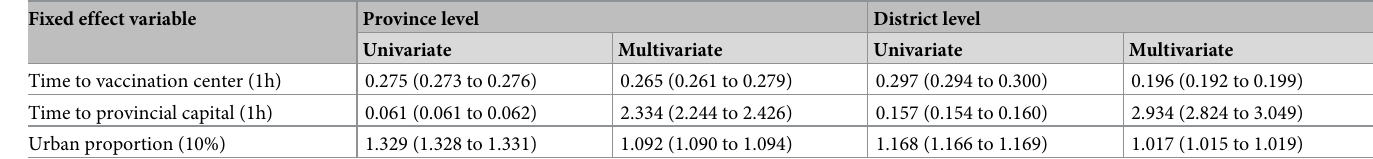
Table 2. Rate ratios for fixed effects (with 95% credibility intervals) in univariate and multivariate Bayesian Poisson regression